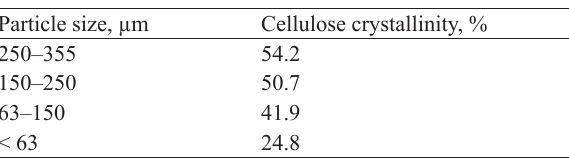
Table 3 Miscanthus cellulose crystallinity according to the diffraction of X-rays Particle size, µm